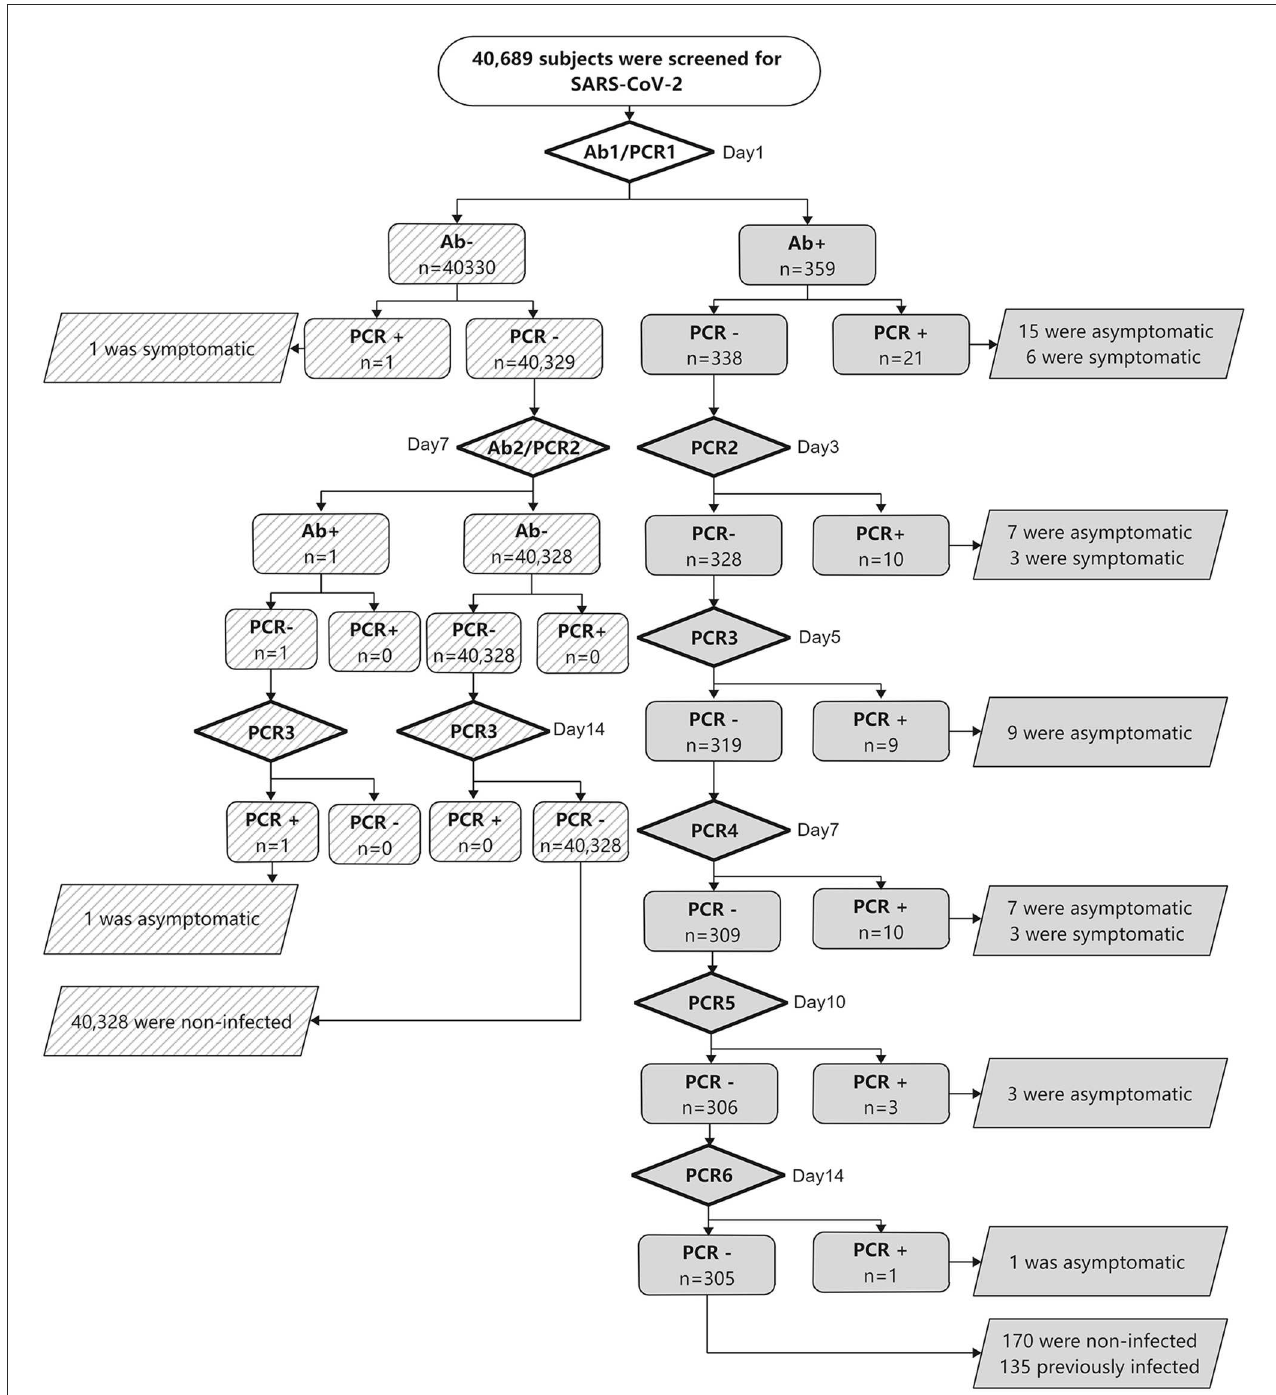
FIGURE1 Results of SARS-CoV-2 screening. Abbreviations: SARS-CoV-2, severe acute respiratory syndrome coronavirus 2; PCR, polymerase chain reaction to detect SARS-CoV-2; Ab, total anti-SARS-CoV-2 antibody level.